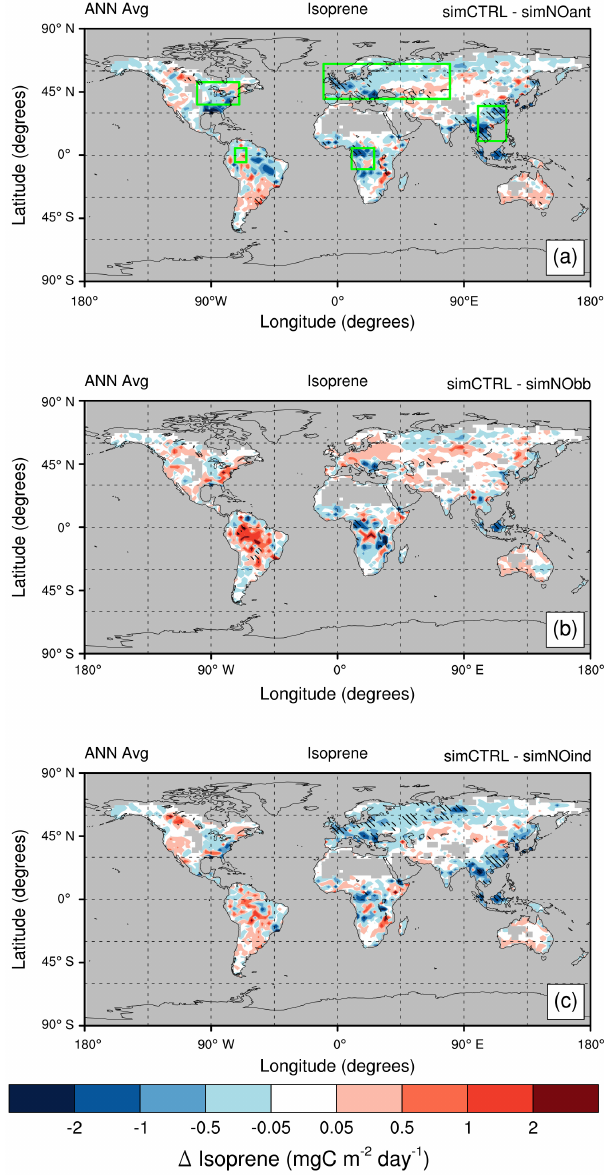
Figure 8. Spatial distribution of annual absolute change in iso- prene emission (in mgCm − 2 day − 1 ) between the control experi- ment (SimCTRL) and sensitivity experiments: (a) without all an- thropogenic emissions (SimNOant); (b) without biomass burning emissions (SimNObb); and (c) without anthropogenic emissions except biomass burning (SimNOind). All experiments are set in a present-day climatic state. Shaded regions indicate areas where changes in isoprene emission are significant at the 95% confidence level. Green boxes on plot (a) highlight key regions selected for